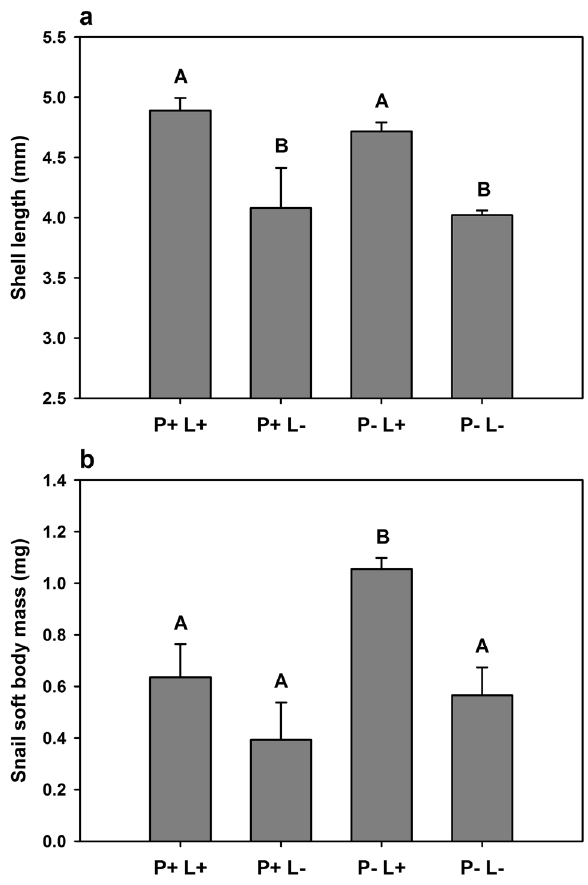
Figure 4. Interactive effects of phosphorus and light on snail growth. Graphs depict the shell length ( a ) and the soft body mass ( b ) of Ancylus fluviatilis and at the end of the grazing phase (7 August), at high phosphorus (P+) and low phosphorus supply (P−) and at high light (L+) and low light availability (L−). Values are mean ± SD of n = 3 replicate flumes. Shell length was significantly increased by high light (two-way ANOVA; F 1,8 = 52.69, p < 0.001), whereas P had no effect. Soft body mass was significantly increased by both high light (two-way ANOVA; F 1,8 = 31.51, p < 0.001) and low P supply (two-way ANOVA; F 1,8 = 20.63, p = 0.002). Different letters indicate significant differences between treatments (Tukey’s HSD post-hoc